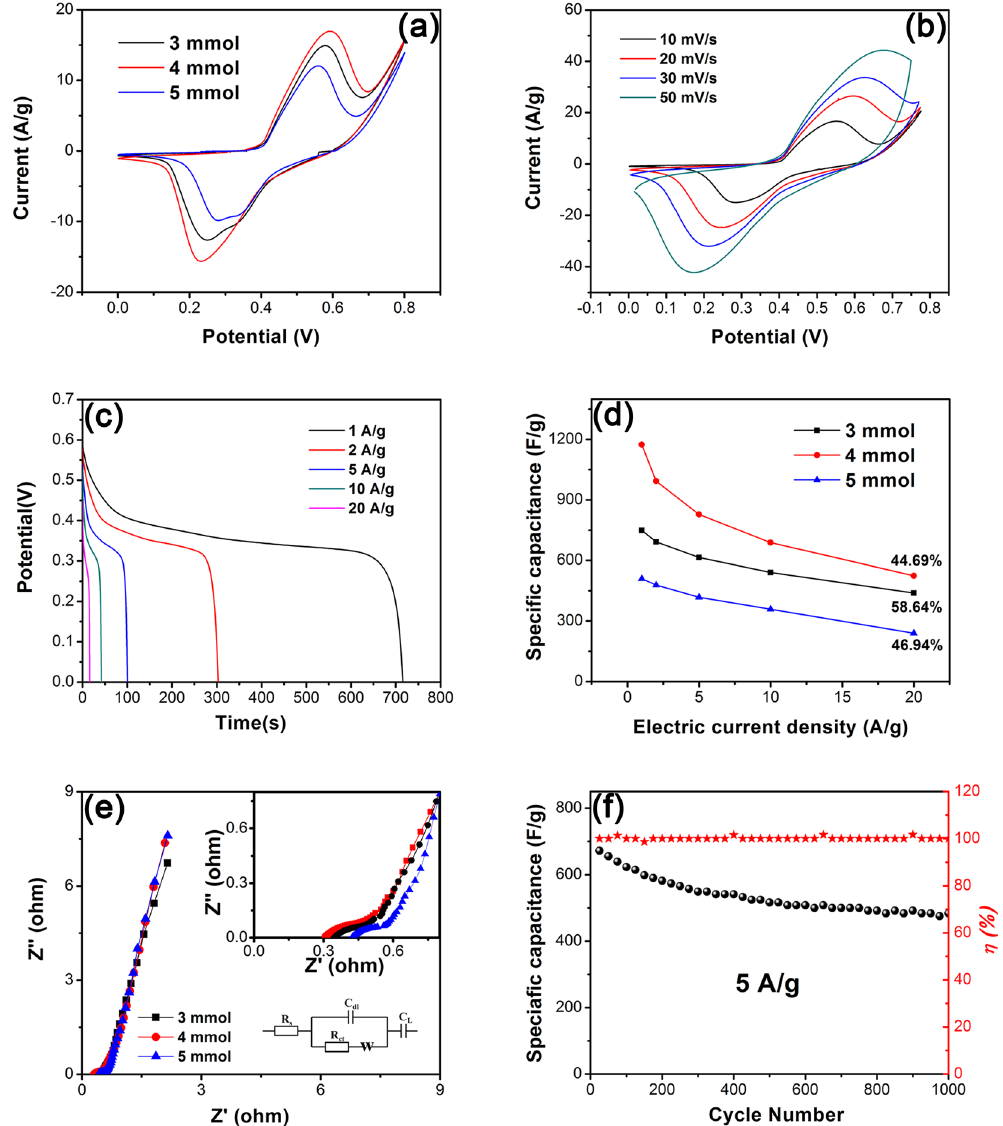
Figure 6. ( a ) Comparison of CV curves of NZZN-3 mmol, NZZN-4 mmol and NZZN-5 mmol electrodes at a scan rate of 10 mV s − 1 ; rate performance curves ( b , c ) of NZZN-4 mmol electrode; ( d ) rate capacitance calculated by galvanostatic charge-discharge curves, and ( e ) EIS with inset showing the close-up views of high- frequency region of NZZN-3 mmol, NZZN-4 mmol and NZZN-5 mmol electrodes, and the electrical equivalent circuit used for fitting impedance spectra. ( f ) Cycling performances and coulombic efficiency of NZZN-4 mmol electrode at a current density of 5 A g − 1 for 1000